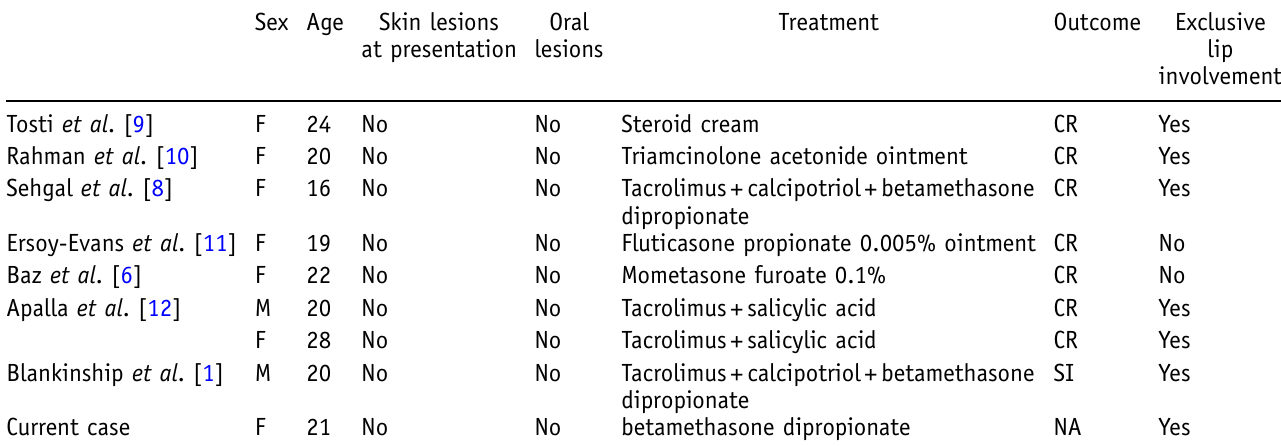
Table I. Summary of cases of psoriatic cheilitis reported in the